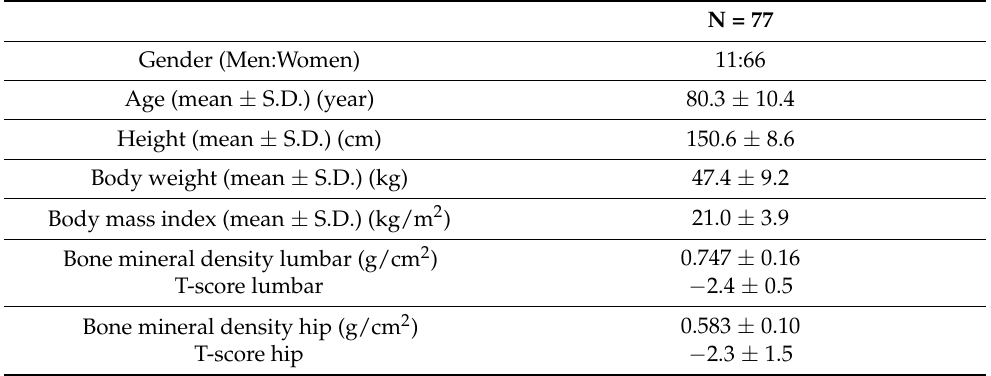
Table 1. Patient